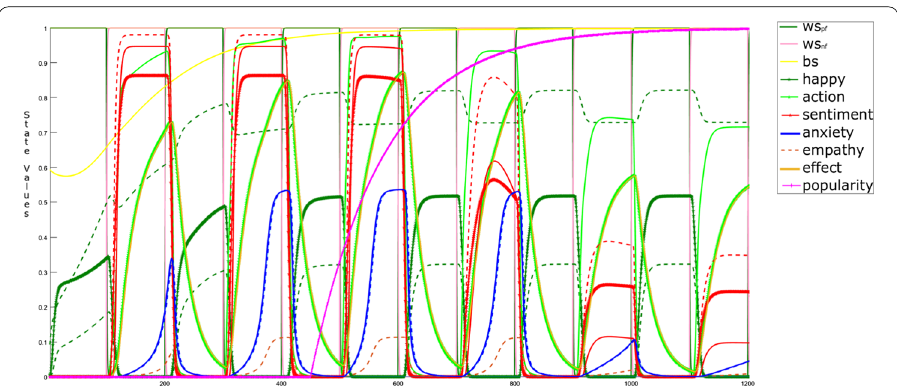
Fig. 6 Simulation of alternative episodes of ws nf